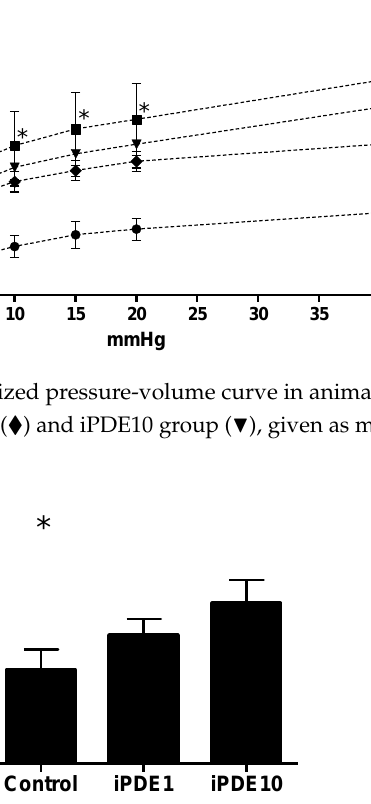
Figure 4. MLI in µm was significantly lower in iPDE1 animals compared to control ( # p < 0.05 vs. control), whereas the iPDE10 group showed a high individual spread within this group. Lungs from 15 of 21 animals were processed for and analyzed by design-based ste- reology [29,30 ]. Lung volumes determined by both Scherle’s method based on Archime- des principle (V Arch ) [30,31] and the Cavalieri method (V Cav ) [30,32] normalized for body weight did not differ between groups (V Arch 16.7 ± 0.9 cm 3 /kg, 13.3 ± 1.6 cm 3 /kg, 15.3 ± 1.6 cm 3 /kg, and 15.1 ± 2.1 cm 3 /kg, respectively, V Cav 22.3 ± 2.3 cm 3 /kg, 21.6 ± 2.2 cm 3 /kg, 19.5 ± 2.5 cm 3 /kg, and 21.5 ± 4.6 cm 3 /kg, respectively, given as mean ± SEM), nor did the surface of the (prospective) alveolar region (S(alv,lung), Table 1). Table 1. Stereology of the lung in 15 of 21 animals (data given as mean ± SEM, * p < 0.05 vs. NO- VENT). NOVENT